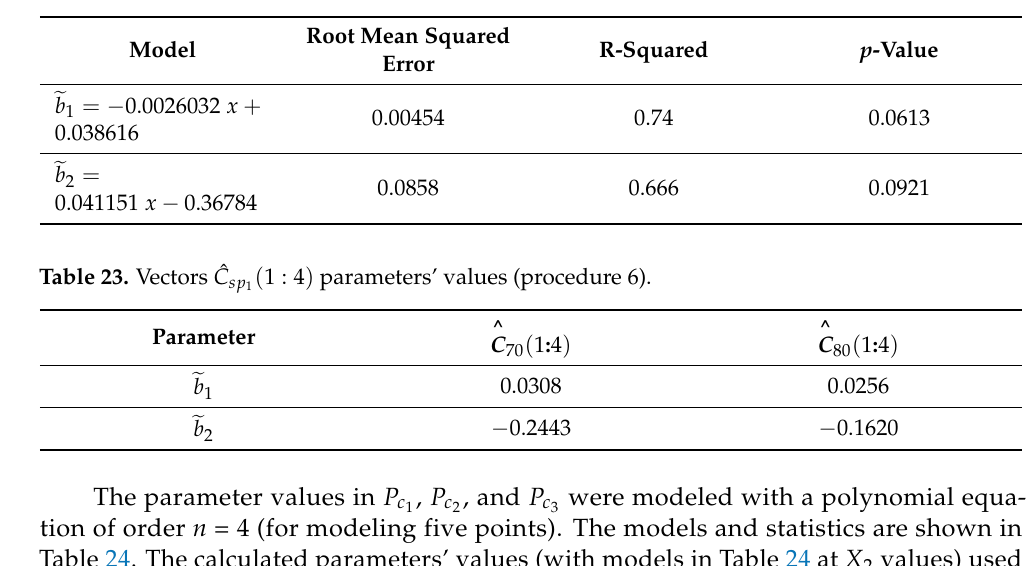
Table 22. Models (for parameters (cid:101) b 1 and (cid:101) b 2 ) and statistics (procedure 6). Model